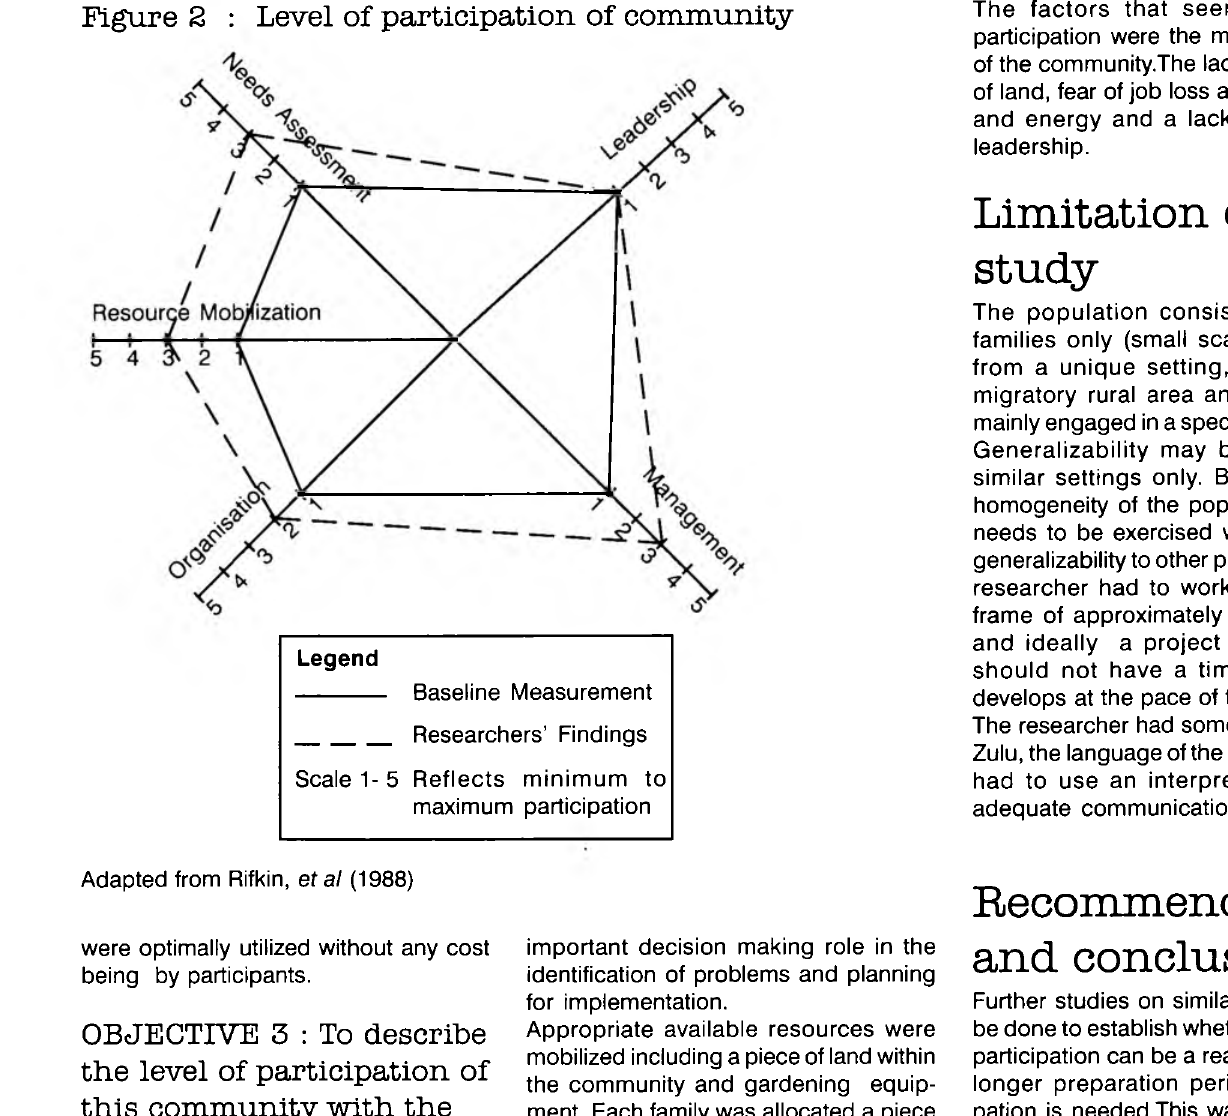
Figure 2 : Level of participation of community